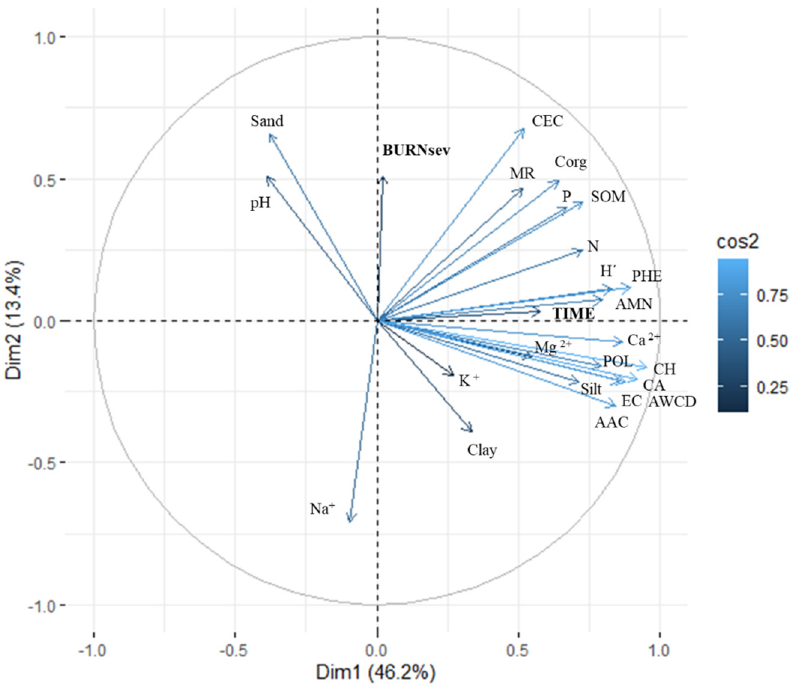
Figure 5. The diagram of principal component analysis (PCA) after varimax-normalization for the main soil physico-chemical properties and community-level physiological profiles (characterized after 96 h of incubation) of the burned plots before (PRE), immediately after burning (1Dafter), and 6 months after (180Dafter) in the MedForECOtron plots: unburned (UNB), low burn severity (LOWsev), and low burn severity (HIGHsev).